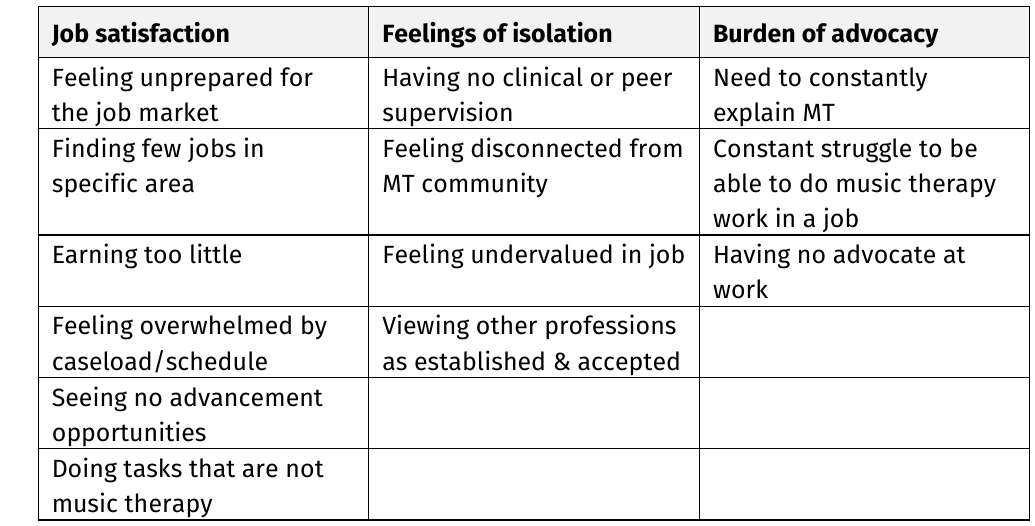
Table 3. Themes Reported in Each